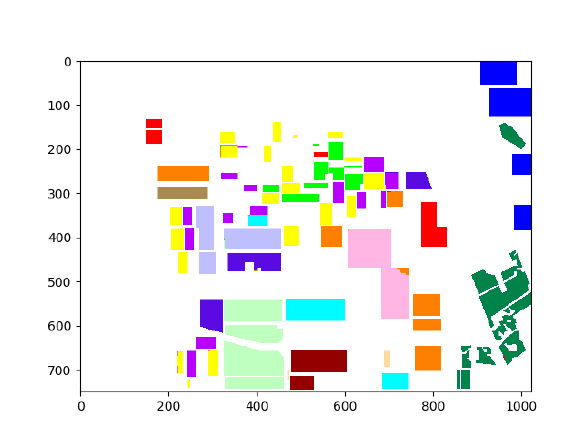
Figure 7. Segmentation results on the FL image for K = 16 , and eFV based on Wishart distribution and nearest neighbors as similarity